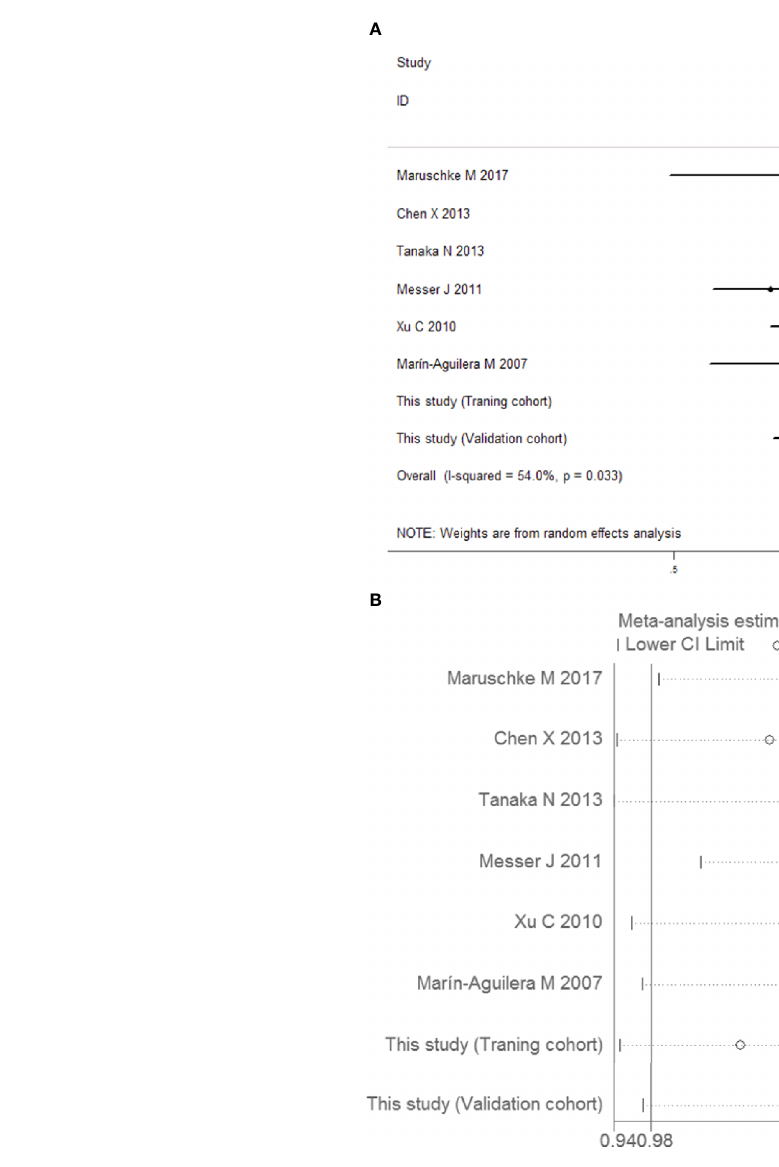
FIGURE 13 | Forest plots for the risk of muscle-invasive UUT-UC in patients with preoperative positive urine cytology. (A) Meta-analysis. (B) Sensitivity